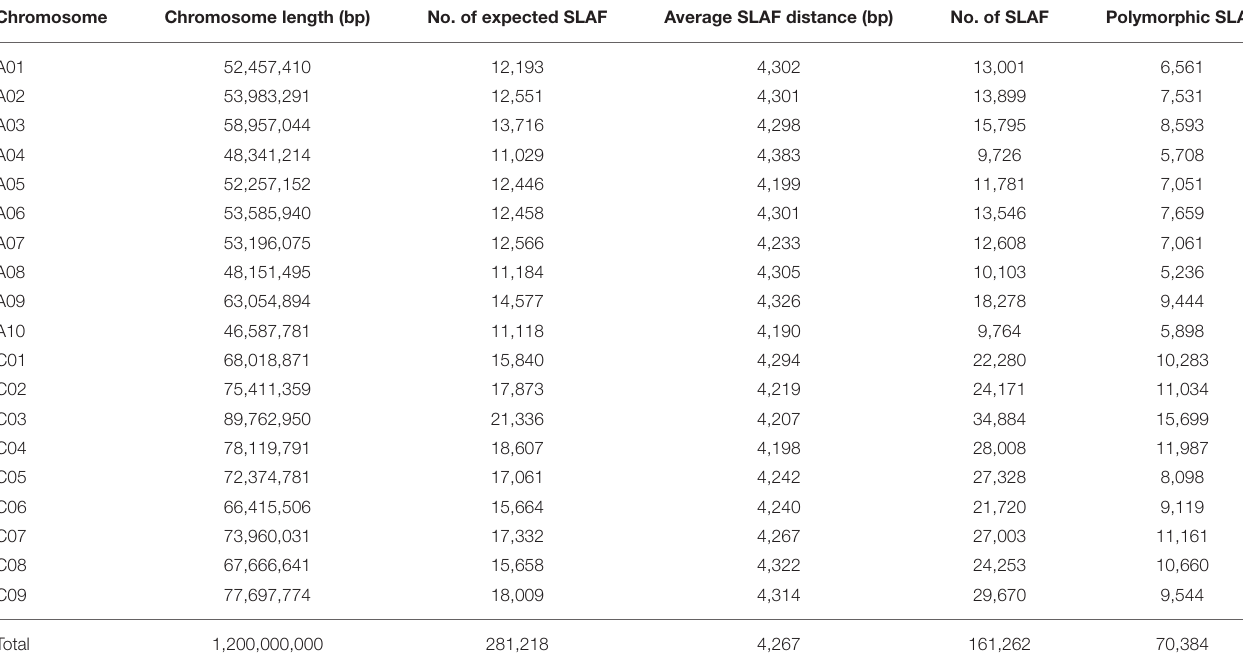
TABLE 1 | Number of SLAF tags distributed on each chromosome of B. napus.